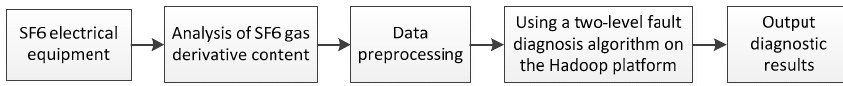
Figure 1. System block diagram for fault diagnosis of SF6 electrical equipment.